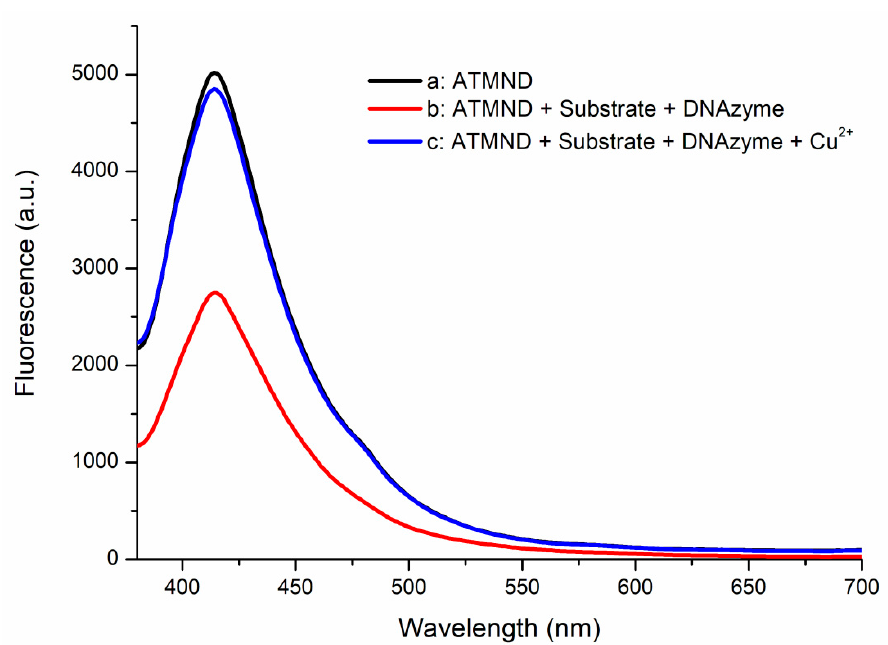
Figure 2. Fluorescence spectra of ( a ) ATMND; ( b ) ATMND with the substrate and DNAzyme; and ( c ) ATMND with the substrate, DNAzyme, and Cu 2+ . Conditions: 30 nM of the DNAzyme complex (30 nM of ATMND, 30 nM of the substrate, and 33 nM of the DNAzyme), 10 nM of CuCl 2 .